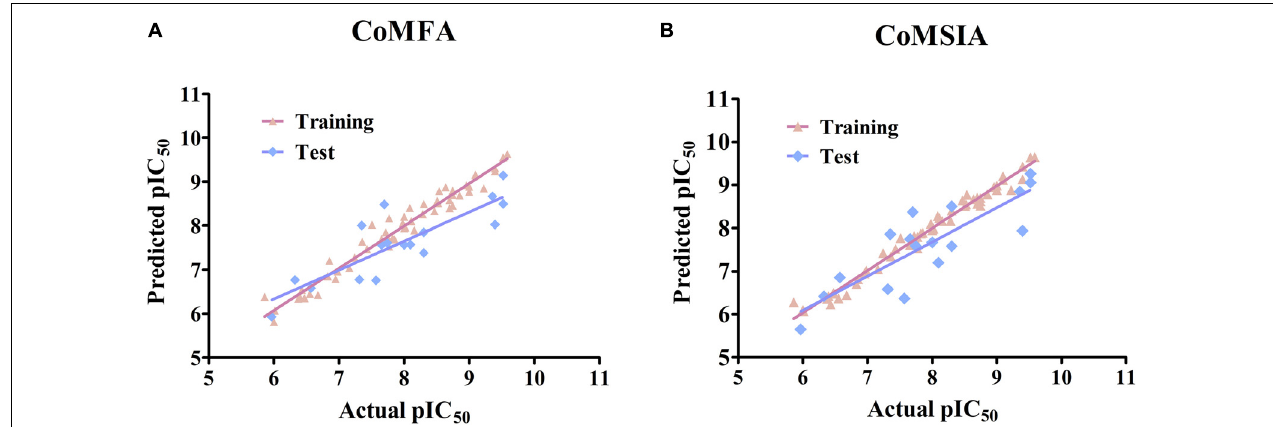
FIGURE 1 | Linear fitting scatter plot of predicted activity values and experimental values for (A) the best CoMFA and (B) the best CoMSIA models.